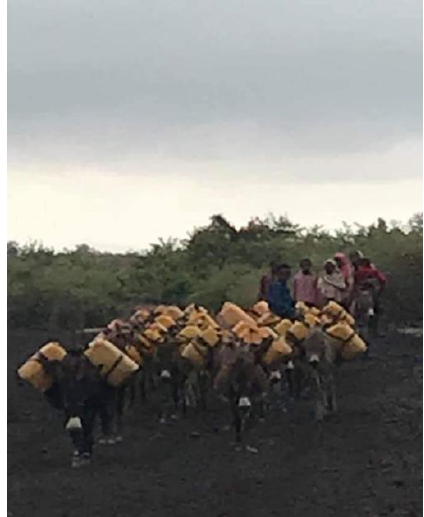
Figure 3. Mount Jaanoo veiled in the cloud, morning, 27 January 2020, southwest of Balaale, and youth with a caravan of water jars from Qooqa (Haroo Roobii). Photo, Author.